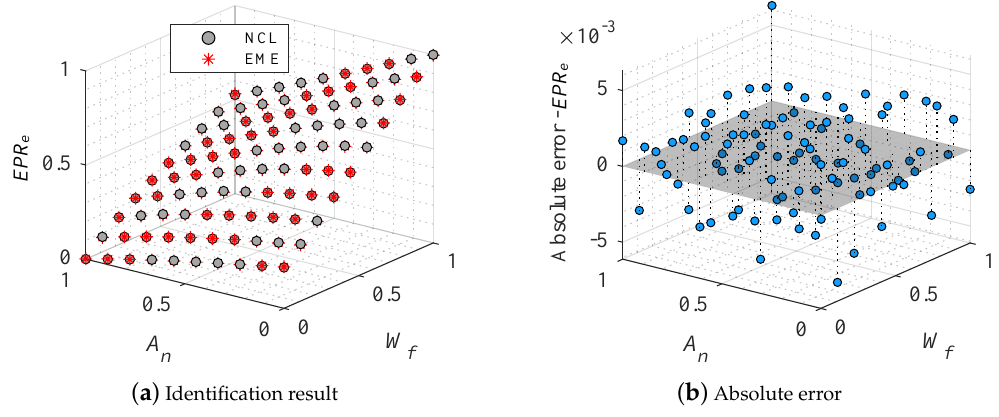
Figure 11. The identification result and absolute error of the EM